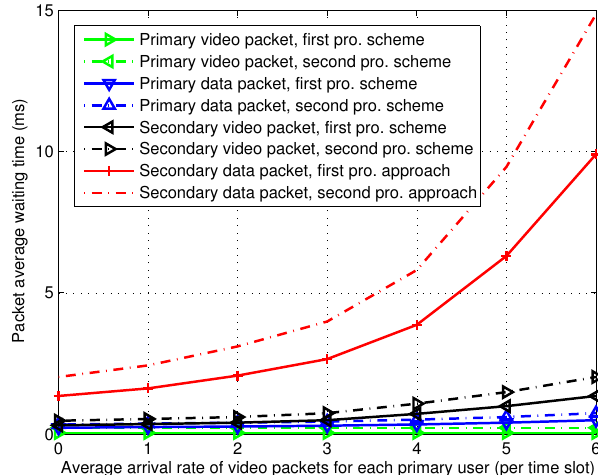
Figure 6. Experimental and analytical results of the primary throughput for second prioritization scheme in our proposed MAC scheme.